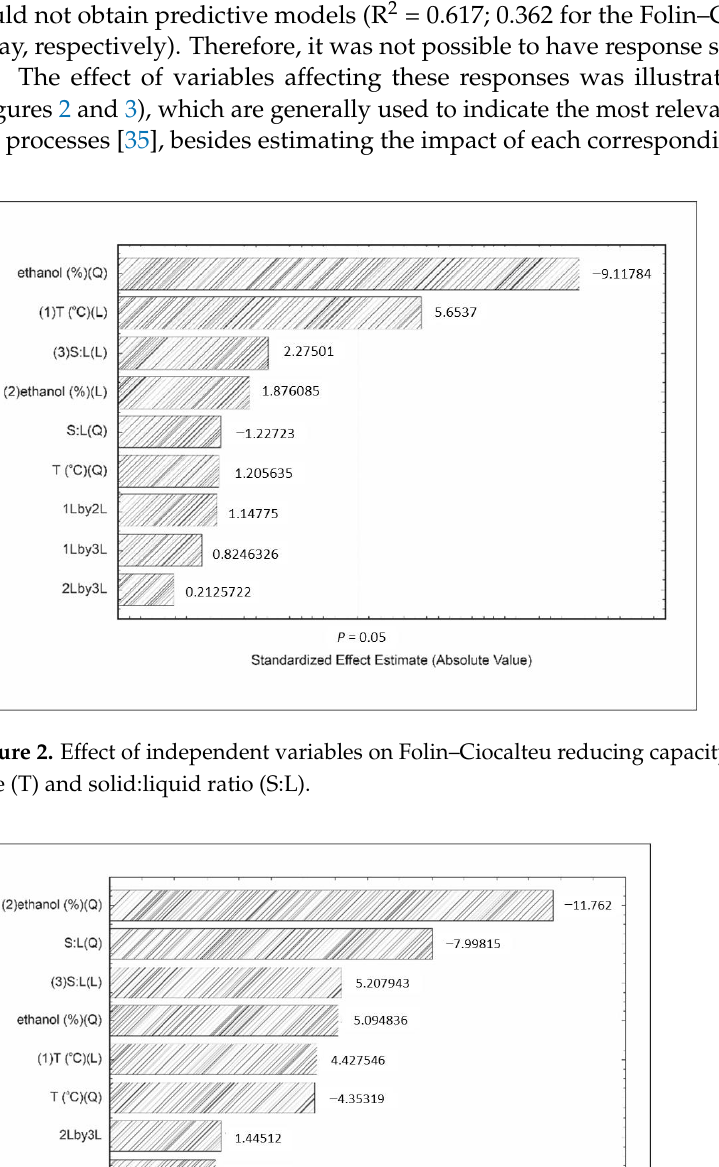
Figure 3. Effect of independent variables on ABTS+ cationic radical scavenging activity, where temperature (T) and solid:liquid ratio (S:L).